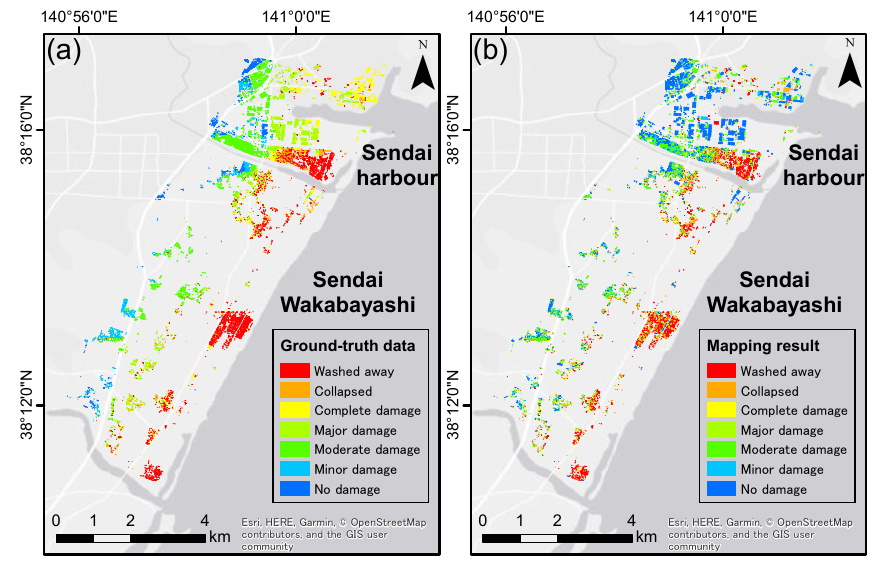
Figure 5. Original classification scheme: ( a ) ground truth data; and ( b ) mapping